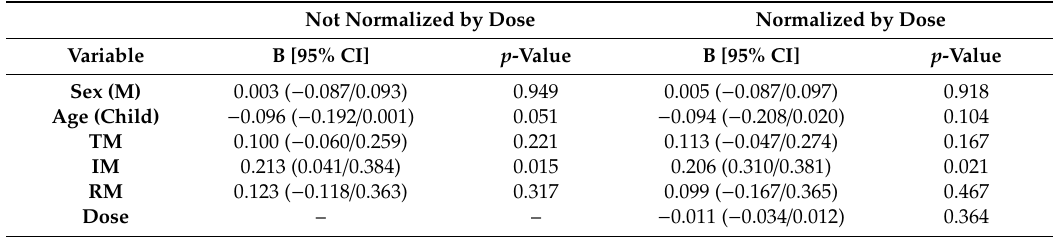
Table 3. Predictive factors of being out of therapeutic range.